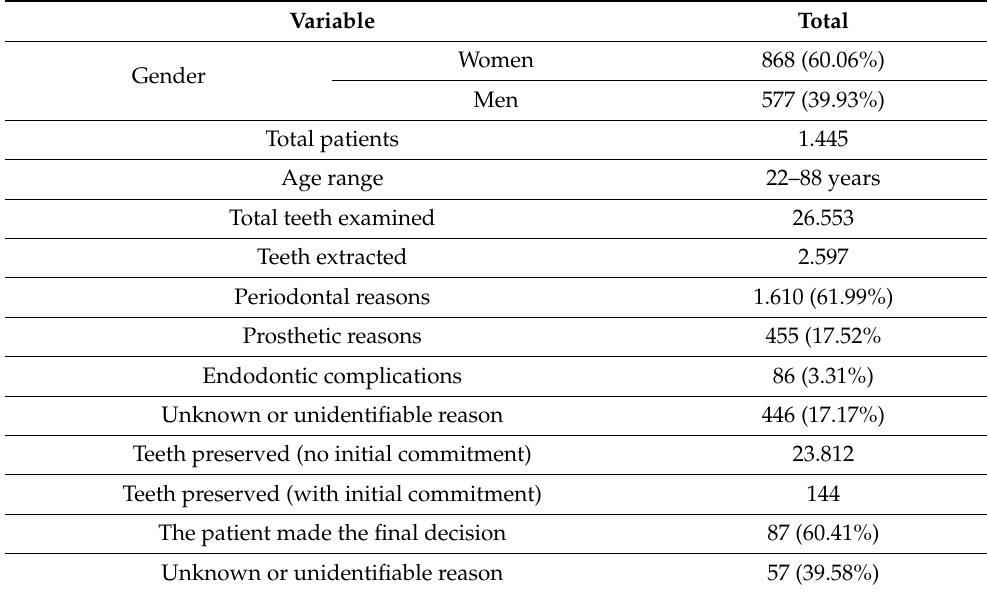
Table 3. Summary of demographic data and teeth